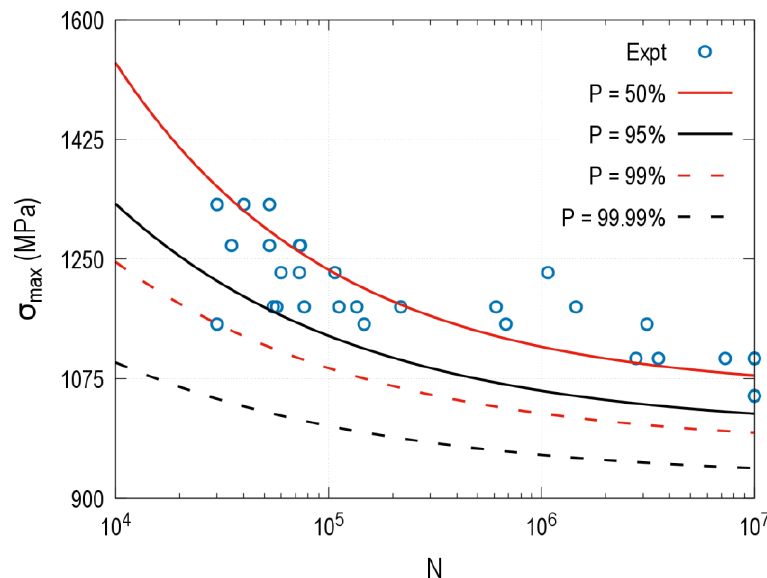
Figure 11. S-N curves of K t = 1, R = 0.1 with different survival rates.